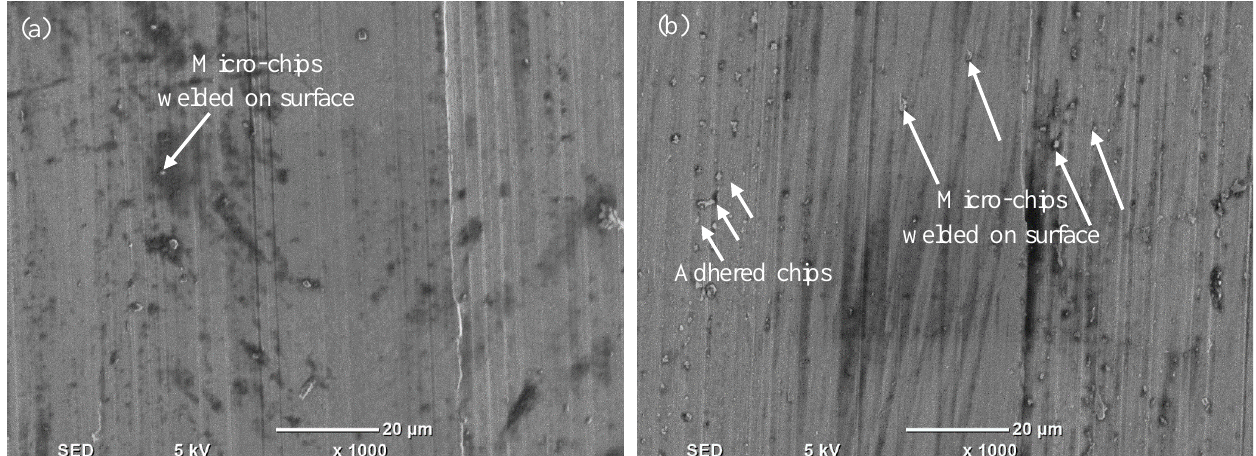
Figure 14. Turned surface images for the two orientations using SEM: ( a ) AL orientation and ( b ) PL orientation at V = 30 m/min, f = 0.1 mm/rev, and d = 0.2 mm.